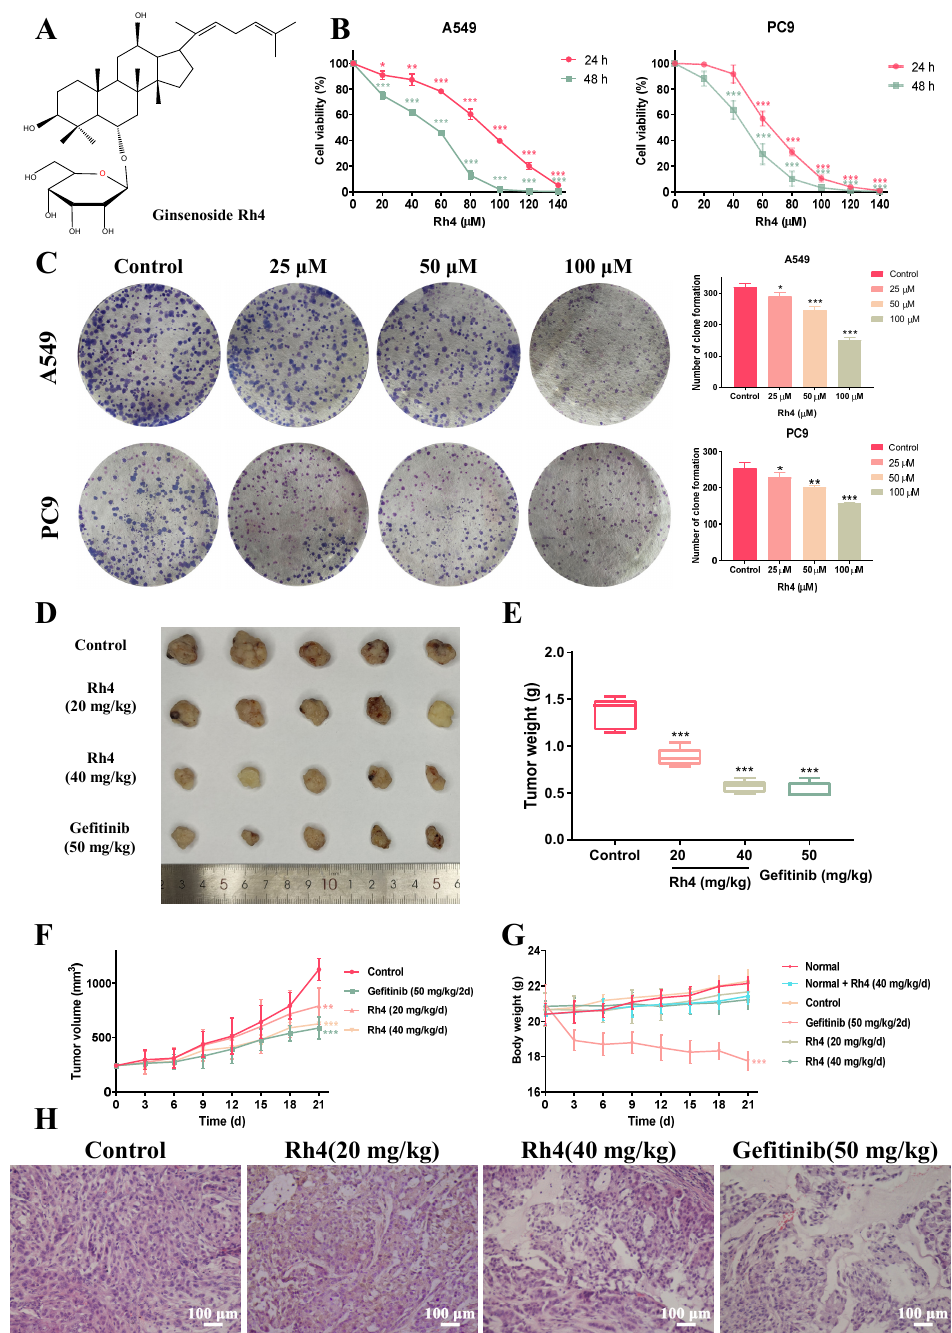
Figure 1. Ginsenoside Rh4 inhibited the growth of LAC cells in vitro and in vivo. ( A ) The chemical structural formula of ginsenoside Rh4. ( B ) MTT assay. Cell viability of human LAC cells A549 and PC9 was measured after treating with Rh4 (0, 20, 40, 60, 80, 100, 120, 140 µ M) for 24 h or 48 h. Rh4 significantly inhibited the proliferation of A549 and PC9 cell in a dose- and time-dependent way. ( C ) Colony formation assay. Rh4 (0, 25, 50, 100 µ M) reduced the colony formation of A549 and PC9. ( D ) Representative pictures of A549-xenograft tumors of the control group, Rh4-treated groups and gefitinib-treated group. ( E ) Tumor weight of xenograft mice in each group on the 21st day. ( F ) Tumor volume and ( G ) body weight were measured every 3 days. ( H ) H & E staining of solid tumors in tumor-bearing groups. Rh4 damaged the tight structure of solid tumor. There were 5 mice in each group. Scale bars = 100 µ m. Data are presented as means ± SD of three independent experiments, * p < 0.05, ** p < 0.01 and *** p < 0.001 compared with the